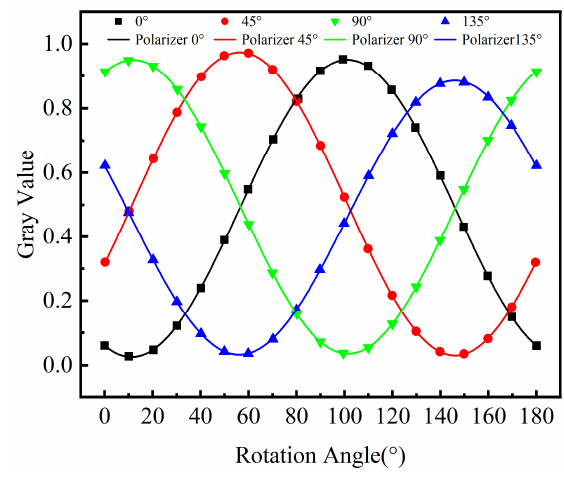
Figure 8. Curve fitting of pixel response gray value.